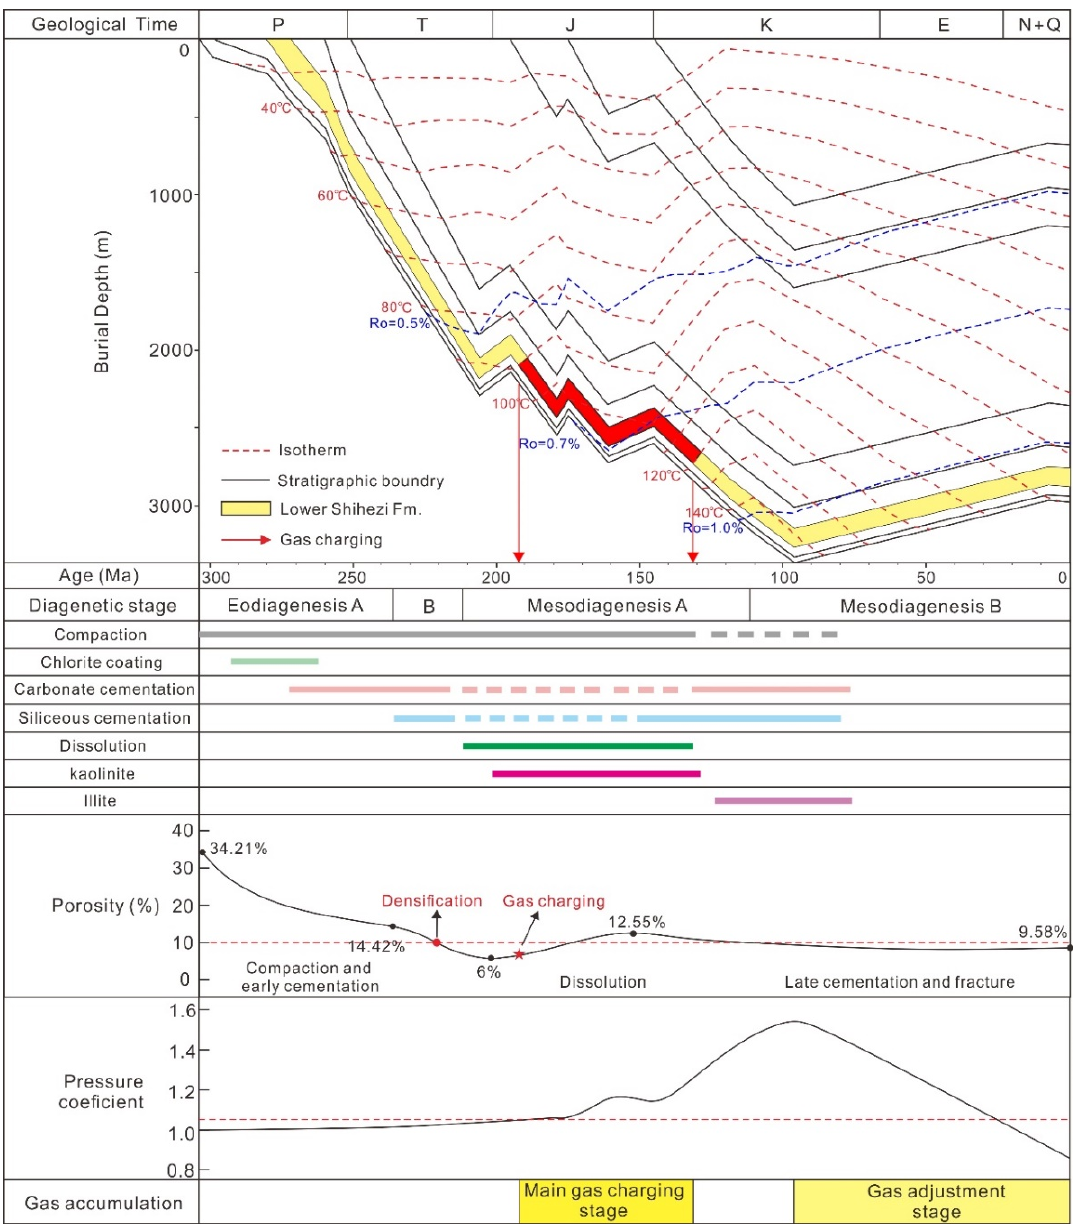
Figure 10. Comprehensive diagram showing the densification process, pressure evolution, and gas accumulation of the sandstone reservoir in the Lower Shihezi Fm., Hangjinqi area.